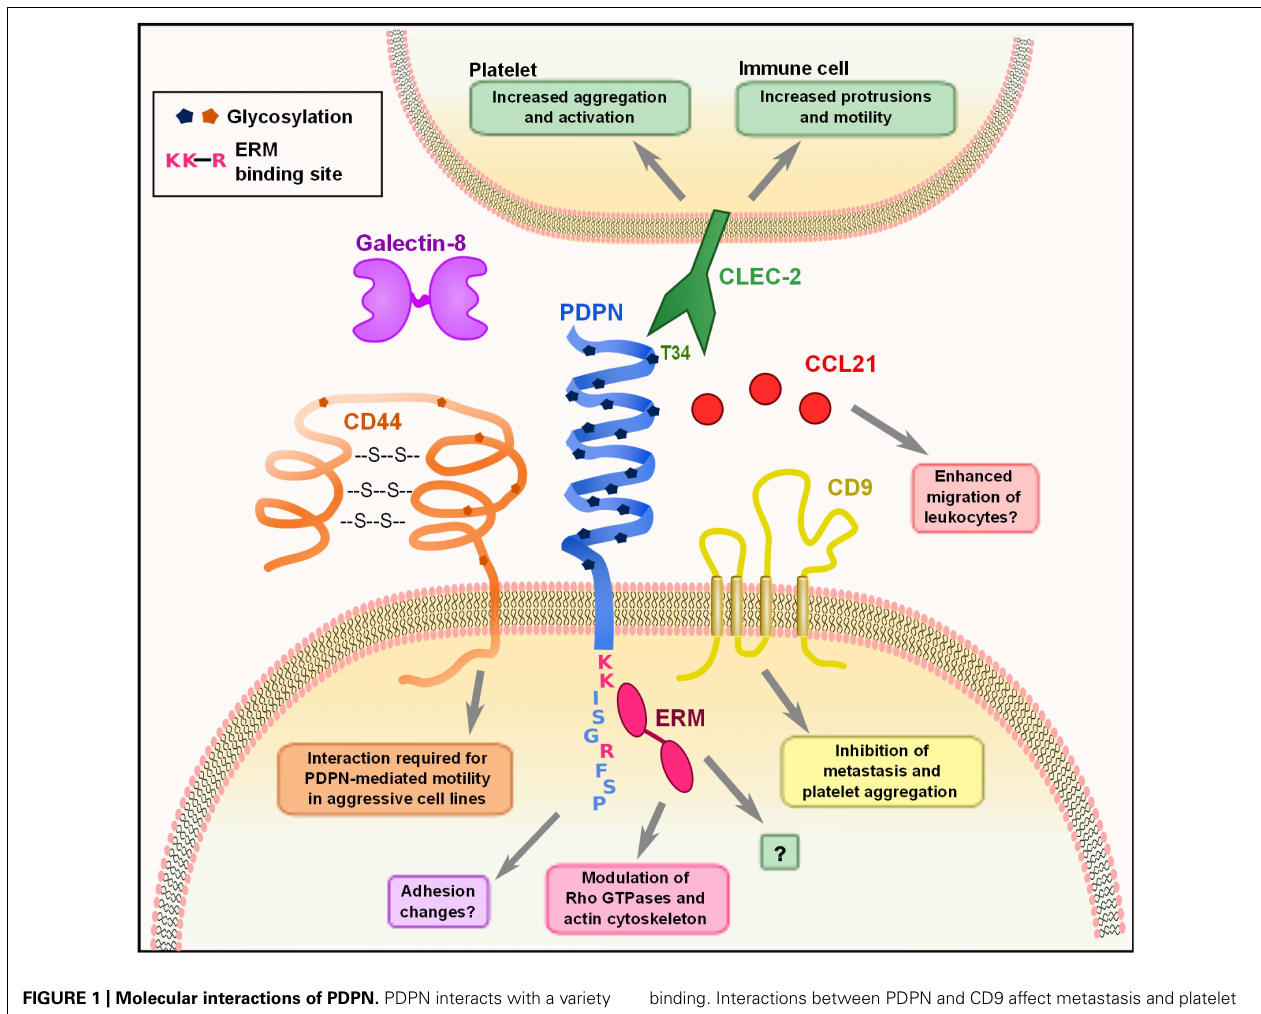
binding. Interactions between PDPN and CD9 affect metastasis and platelet aggregation.The engagement of PDPN by CLEC-2 causes increased motility in DCs and aggregation and activation of platelets. PDPN binds with high affinity to the chemokine CCL21 and while the consequences of this effect have not been examined, it may play a role in facilitating leukocyte migration. Finally, PDPN binding to galectin-8 may modulate adhesion of